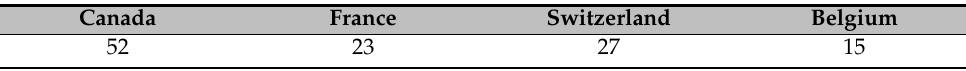
Table 1. Participants